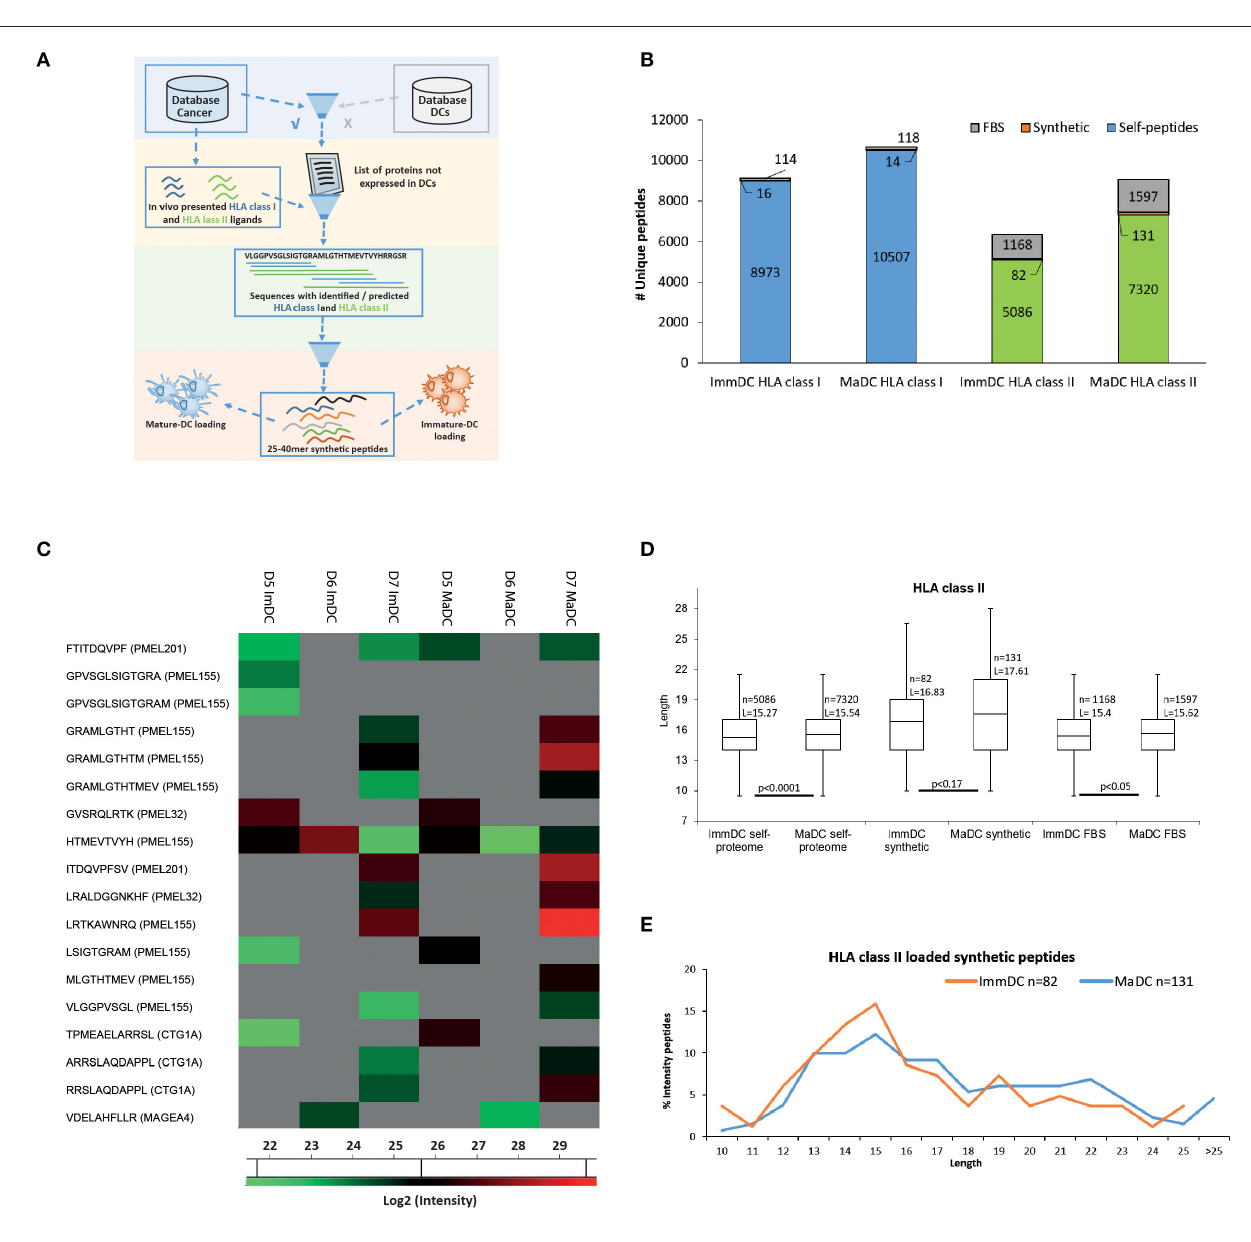
FIGURE 4 | Dendritic cell exogenous loading. (A) Scheme of synthetic peptides selection for exogenous dendritic cell loading. In-house cancer and dendritic cell databases, respectively built by measuring protein, HLA class I and class II-bound peptide expressions from tumor tissues/cell lines and CD14 + , immature, and mature dendritic cells. The cancer database was filtered out for proteins which were also found expressed in the dendritic cell database. HLA class I and II-bound peptides identified by MS were mapped on the remaining list of proteins. Only protein sequences which included multiple HLA class I and II identified peptides (hotspots’ of antigen presentation) were further selected. Selected “hotspots” sequences (25 to 40a.a) were further tested with predictions for HLA class I binding of the most common HLA-A and -B alleles. Seven remaining long peptides were selected for synthesis and exogenous loading to immature and mature dendritic cells. (B) Identified (FDR 5%) HLA class I and class II-bound FBS-derived (gray) from 3 combined donors, self- (blue for class I and green for class II) and derived from the exogenously loaded synthetic (orange) peptides from immature and mature dendritic cells. (C) Heat map of log2 intensity values of HLA class I peptides derived from the exogenously loaded synthetic peptides from immature and mature dendritic cells of 3 donors. (D) Box plot of length distributions of respectively HLA class II from cell self-proteome, derived from the exogenously loaded peptides and FBS-derived peptides are plotted for immature and mature dendritic cells of 3 donors. Average length (L) for each cell type is reported together with the statistical significance (unpaired t -test, p -values). (E) Intensities of HLA class II synthetic peptides identified in immature and mature dendritic cells were summed up for each peptide length and then normalized by the total intensities of identified HLA class II synthetic peptides.